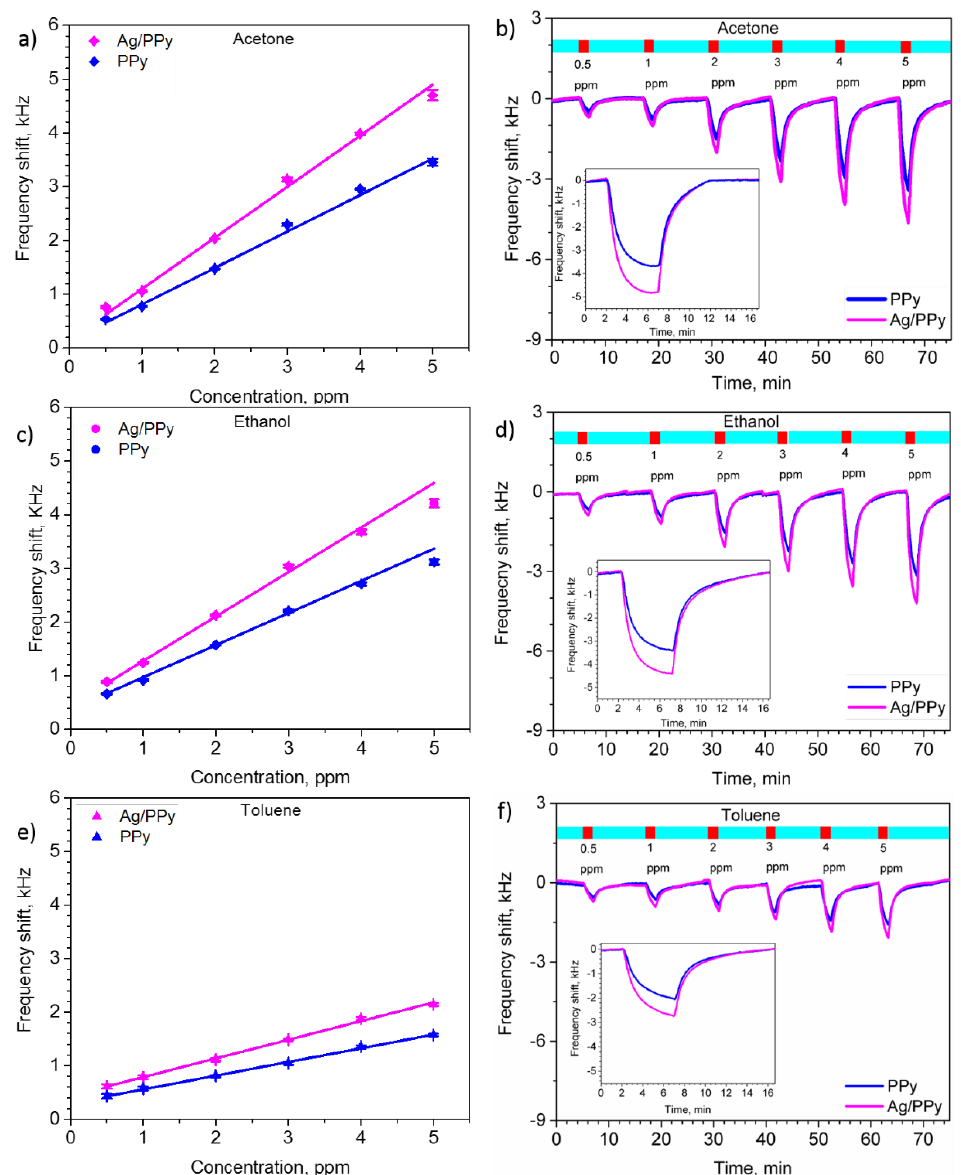
Figure 4. Calibrations curves and dynamic responses of the L-SAW sensors (based on PPy and Ag/PPy) for acetone ( a ) and ( b ), ethanol ( c ) and ( d ), and toluene ( e ) and ( f ). The insets in ( b ), ( d ) and ( f ) display the time dependent response to 5 ppm of each gas.